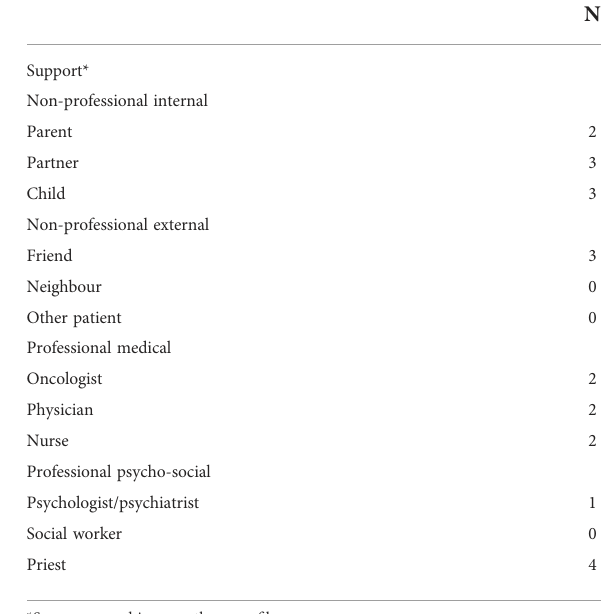
TABLE 4 Cancer therapy in fi